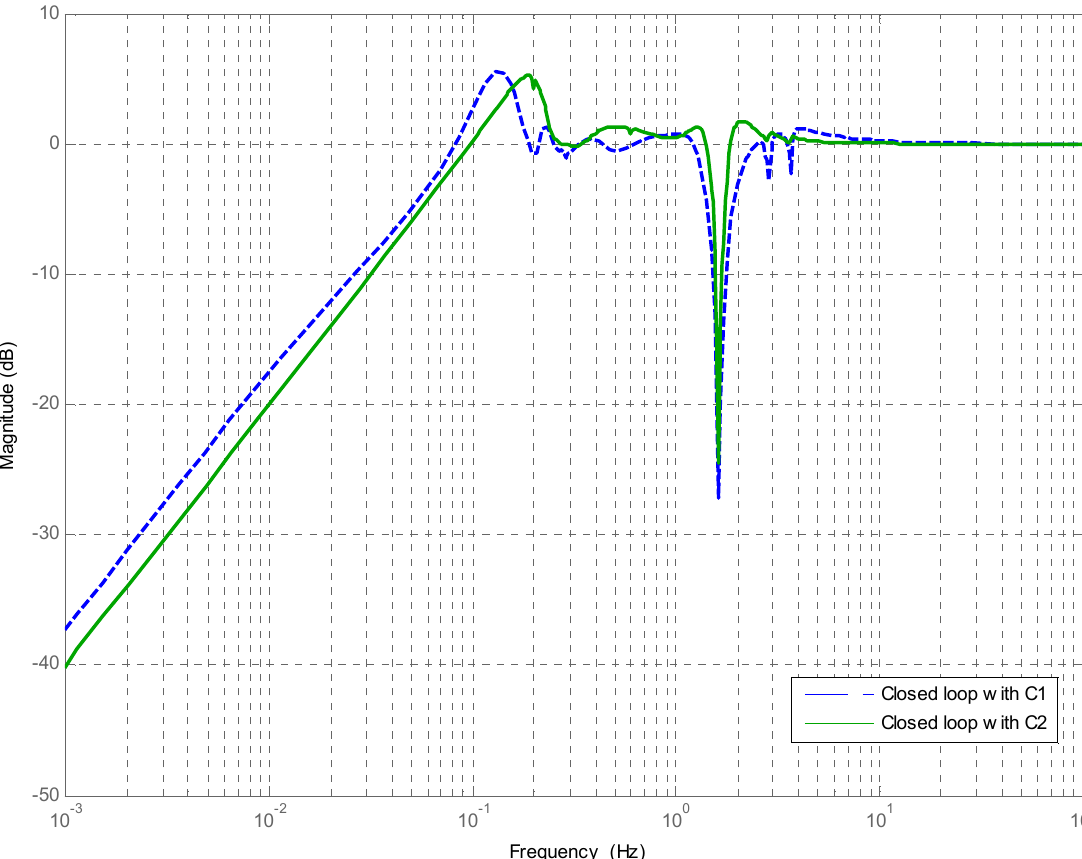
Figure 13. Generator speed output sensitivity